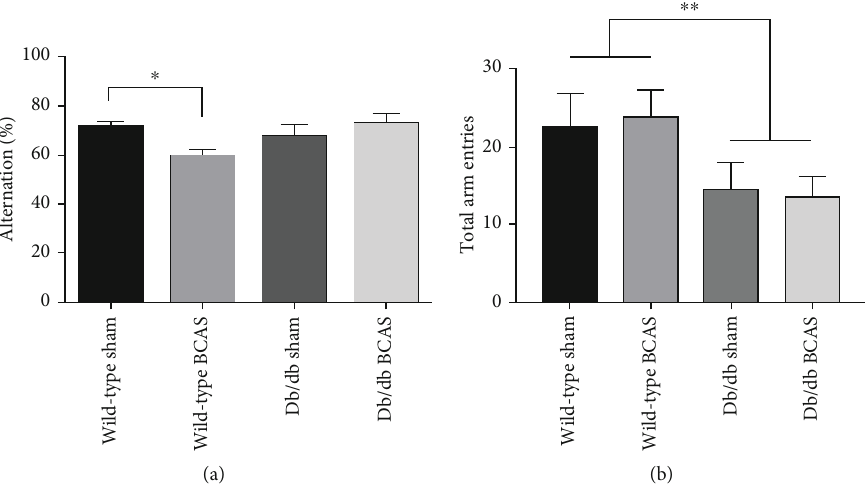
Figure 2: Spatial working memory in mice from di ff erent groups. (a) Histogram represented the alternation outcome of mice that underwent the 8-minute Y-maze test. (b) The number of total arm entries of mice from di ff erent groups in the Y-maze test. N = 9 − 14 , data were presented as the mean ± SEM . ∗ p < 0 : 05 , and ∗ p < 0 : 01 .